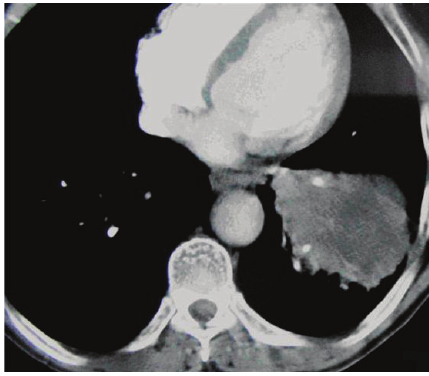
Figure 1: Thoracic computed tomography (a hypodense mass lesion at the left pulmonary lobe).